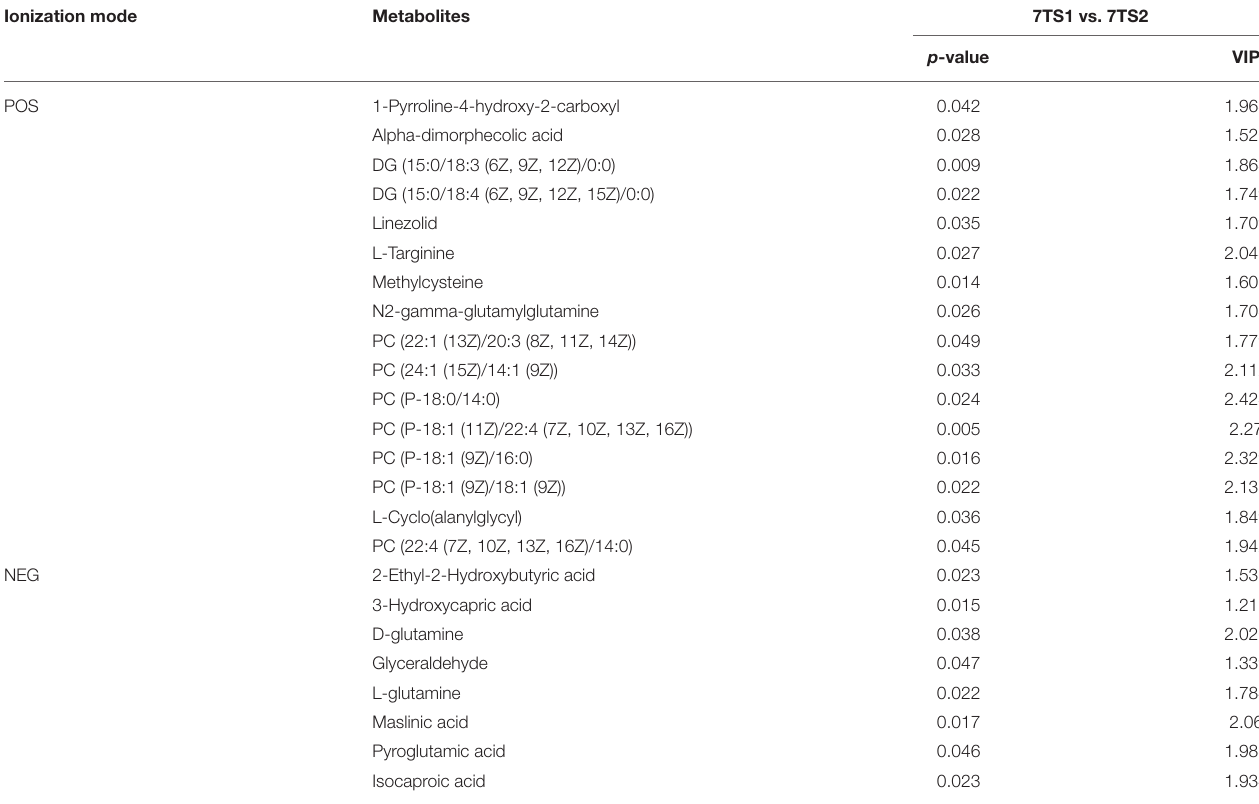
TABLE 2 | In two ionization modes, one-dimensional, and multi-dimensional analysis results of differential metabolites from the 7-day prognosis group are